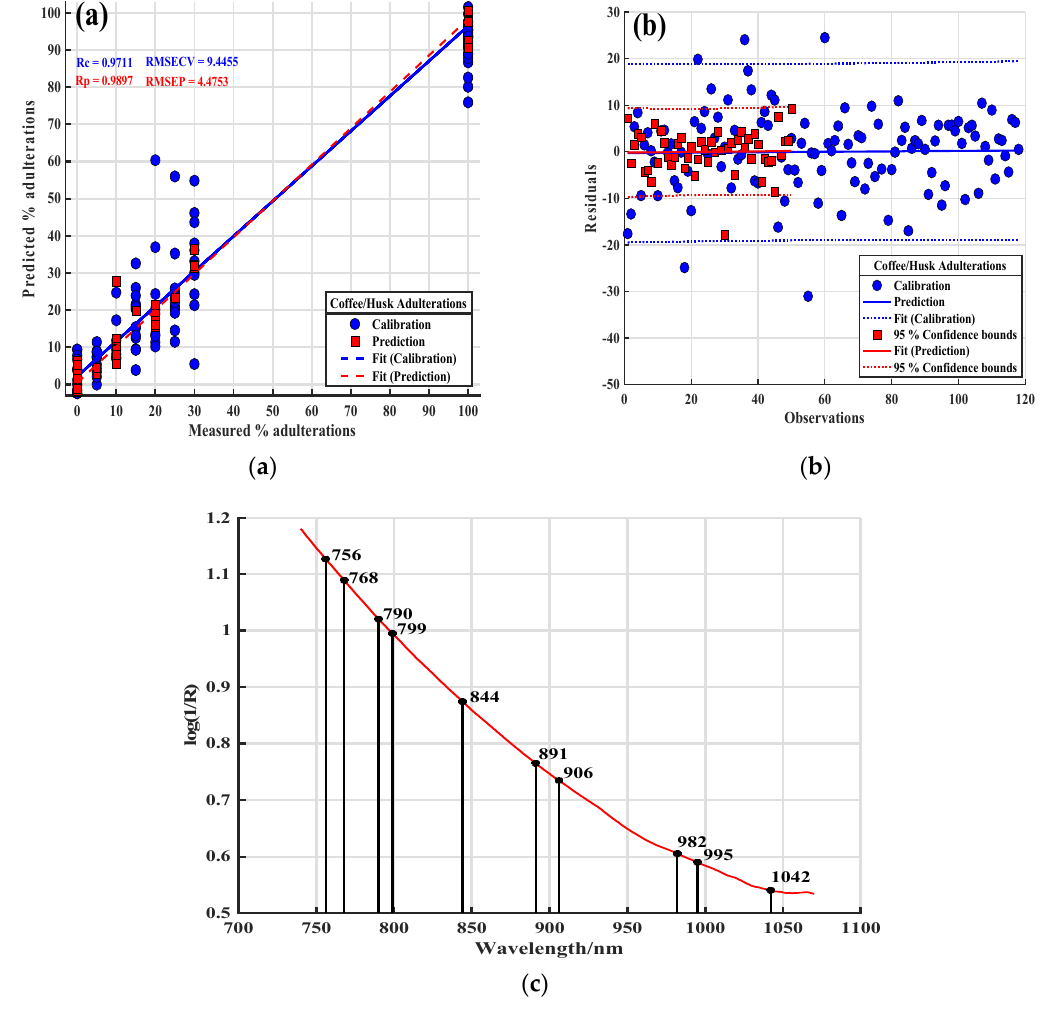
Figure 6. Scatter plots of SPA ‐ PLS model with NIR estimation and experimental concentration ( a ) and residual plot ( b ) and ( c ) model plot.